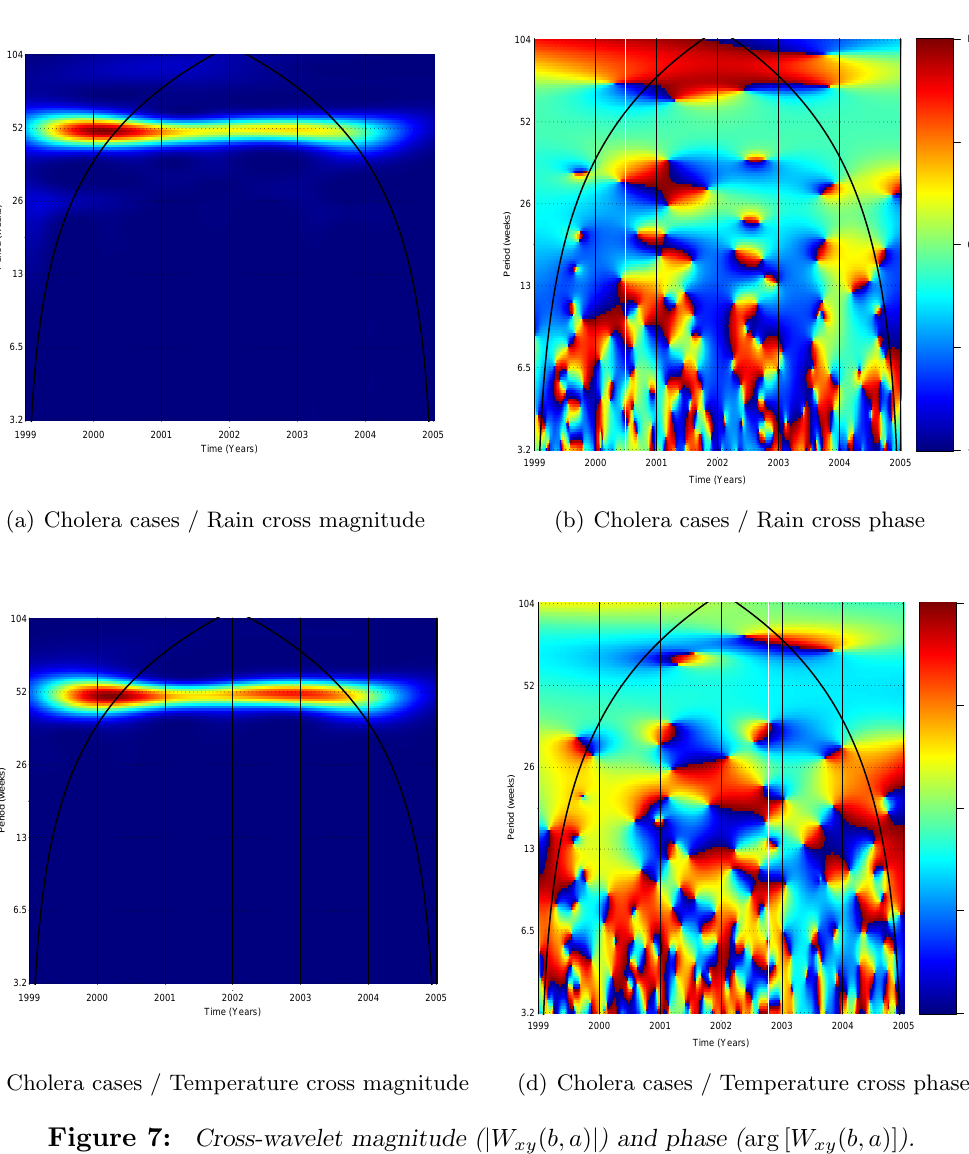
sidered. It was found that the accumulation of temperature smoothed the signal into a sinusoidal shape, which effectively filtered out all information at scales below 52 weeks. Despite this loss of detail, it was found that an accumulation of 14 weeks yielded improved phase difference